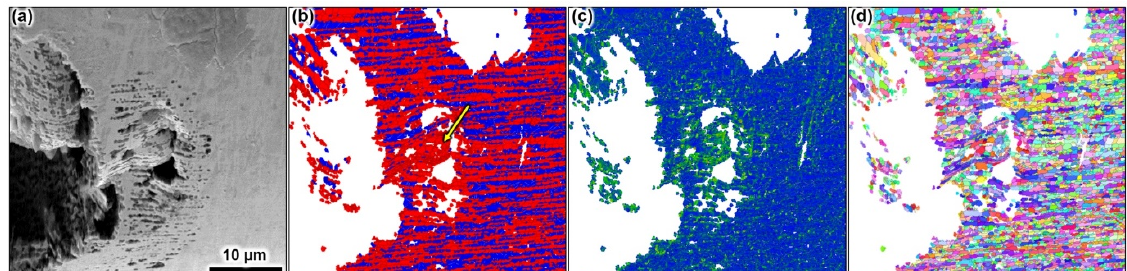
Figure 5. SEM/EBSD analysis over a corrosion pit formed after potentiostatic polarisation at 900 mV vs. Ag/AgCl in 1 M NaCl solution at pH 3 and 60 °C. The pit shows a partially collapsed perforated lacy cover. The micrograph in ( a ) is the BSE image, ( b ) the corresponding EBSD phase map with ferrite (red) and austenite (blue), ( c ) the corresponding local misorientation map showing strain localisation (green), and ( d ) shows the corresponding grain orientations. The scale bar in ( a ) applies to all images.